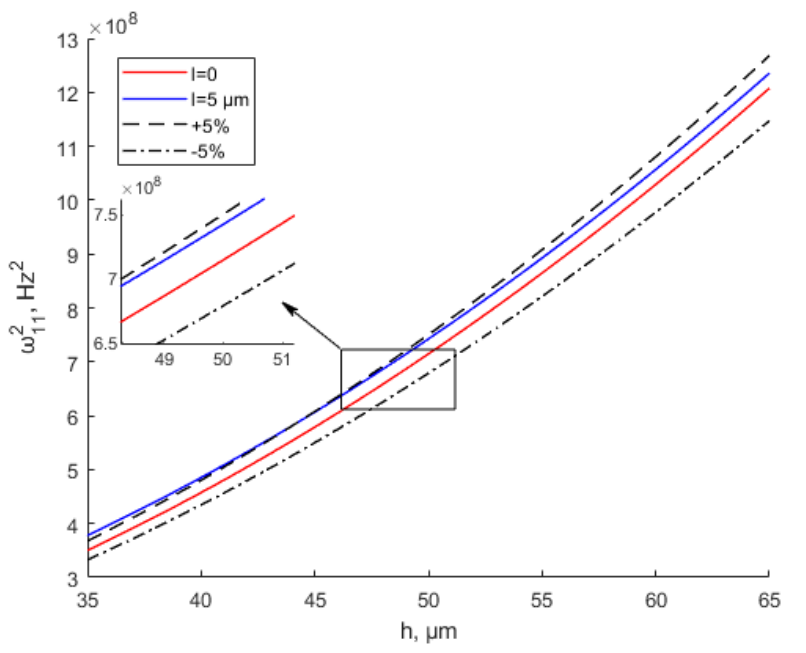
Figure 12. Modified couple stress and classical natural frequency of thin plates shown with small deviation when l = 5 μ m.